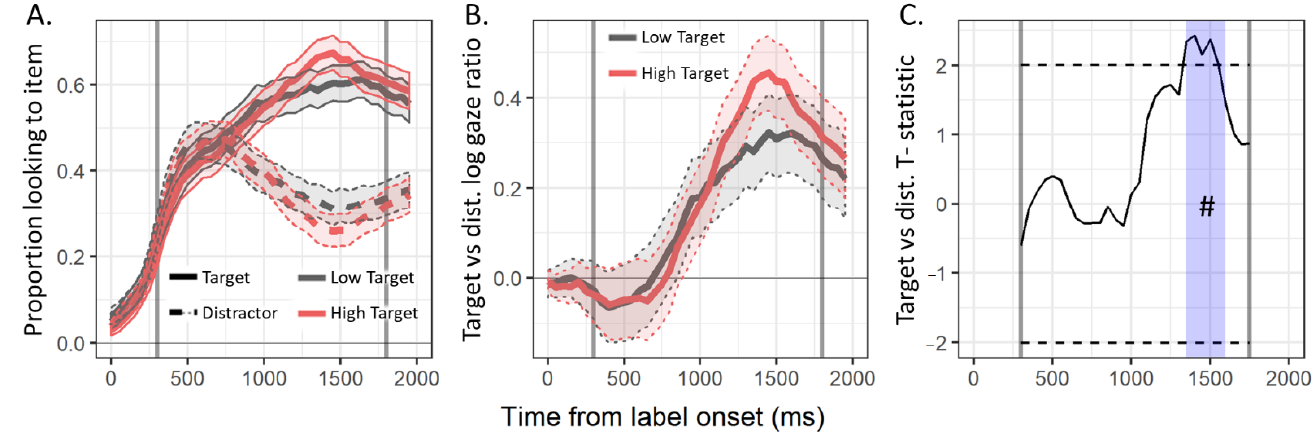
Figure 5. Post-labeling test period time course plots of ( A ) the proportion of fixations to the target (solid line) and distractor (dotted line) items for normative high (red) and low (grey) target conditions, ( B ) the log gaze ratio of fixations to normative high (red) vs. low (grey) items, and ( C ) the pointwise T-statistics comparing target vs. distractor log gaze ratios for high vs. low items and a period of consecutive significant differences identified by the cluster analysis (light blue), calculated over 50 ms time bins (with SE ribbons). # p < 0.1.